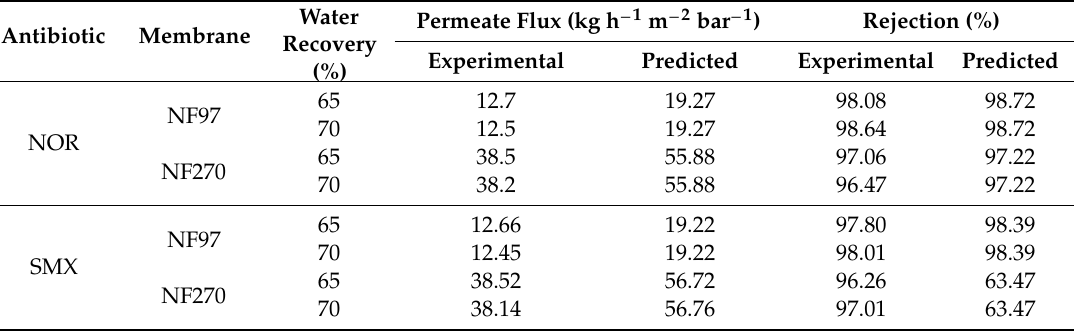
Table 6. NF as a tertiary treatment of urban wastewater: antibiotic rejection and permeate flux.